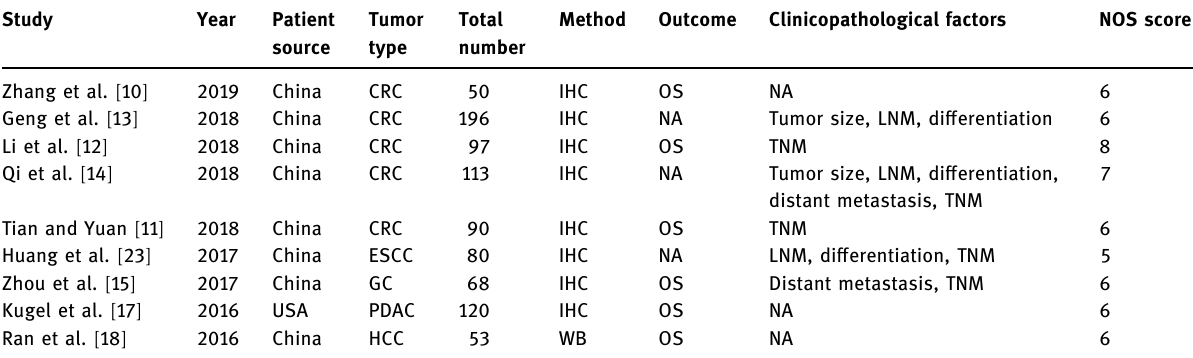
Table 1: Characteristics of the studies included in this meta -